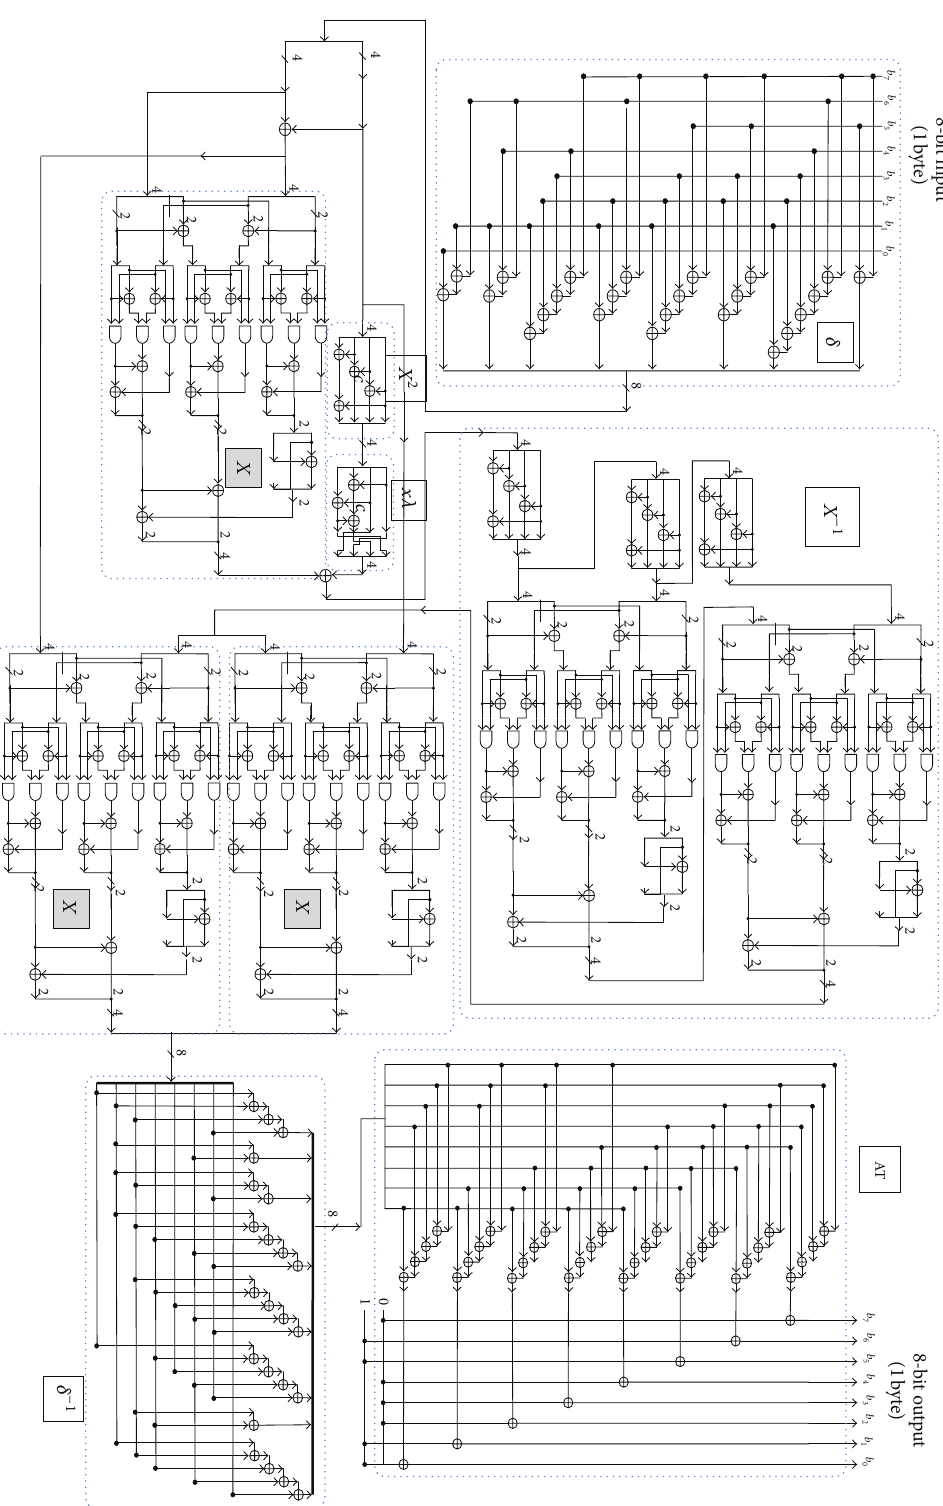
Figure 9: The complete schematic circuit for the forward SubBytes with a total gate count of